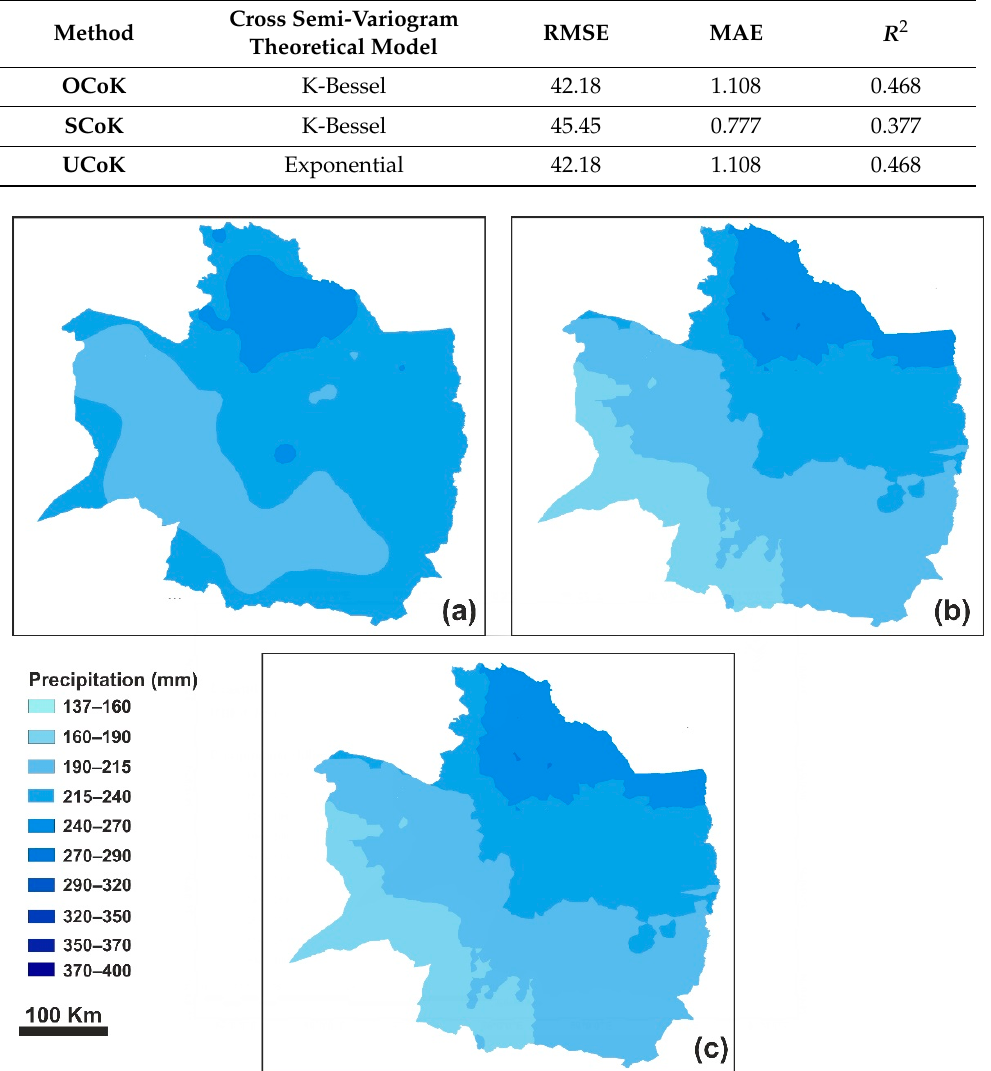
Table 5. Error values and R 2 for the three applied Co-Kriging methods.